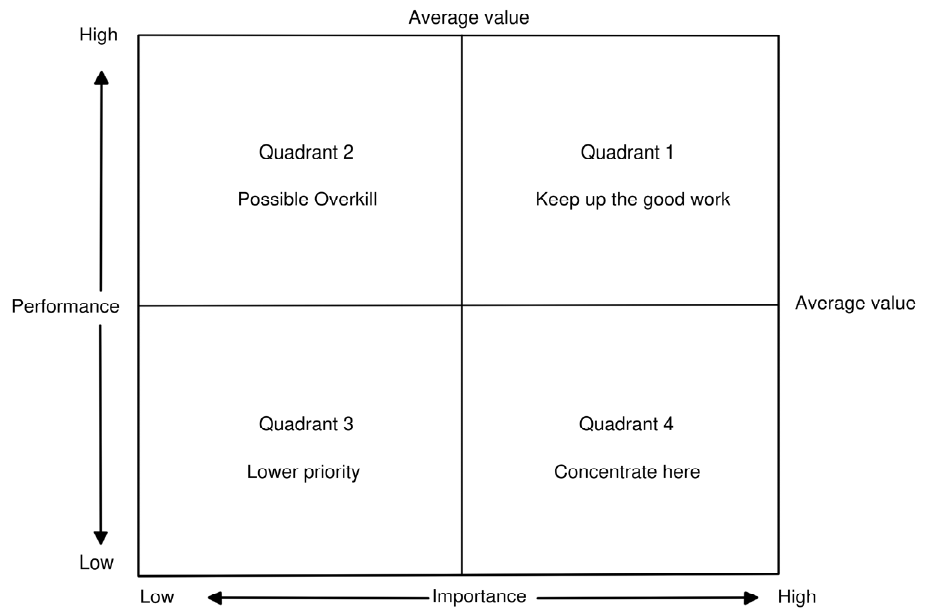
Figure 1. IPA matrix.